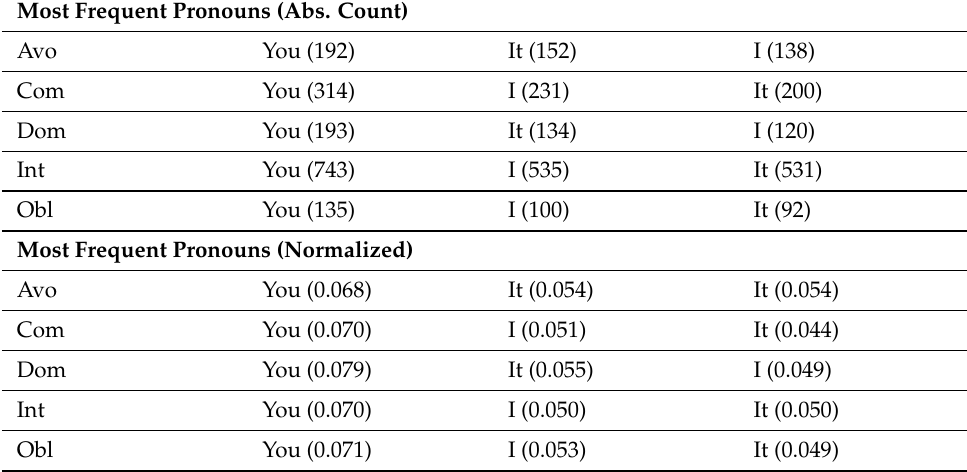
Table 6. Most frequent personal pronouns (absolute counts and normalized by the total number of words) that occurred in each of the documents.